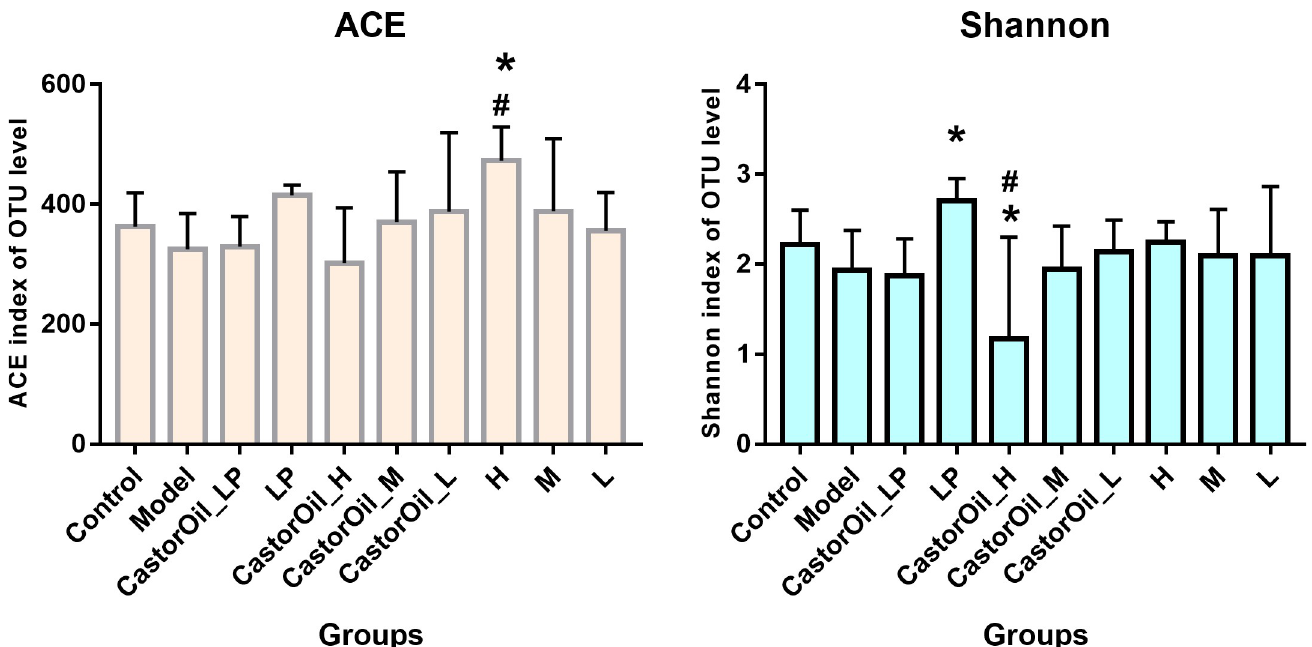
Fig 5. Evaluation of alpha diversity for the gut microbiota from intestine content. LP (loperamide), H (high dose of FengLiao), M (medium dose of FengLiao), L (low dose of FengLiao). 1 g/ml FengLiao (H), 0.5 g/ml FengLiao (M), 0.25g/ml FengLiao (L) and 5mg/kg loperamide were pretreated in CastorOil_H, H, CastorOil_M, M, CastorOil_L, L, CastorOil_LP, LP groups once a day for three days respectively. 30 min after the last drug administration, 0.5ml castor oil was used to induce diarrhea in CastorOil_H, CastorOil_M, CastorOil_L and CastorOil_LP groups for 4 h and the intestinal contents were sequenced for bacterial 16S rRNA. Bar graphs show ACE index and Shannon index of OTU level. X axis represent groups’ name. Column represents the mean ± SD of five mice.versus model group: � p < 0.05, versus control group #p < 0.05, ANOVA Test.